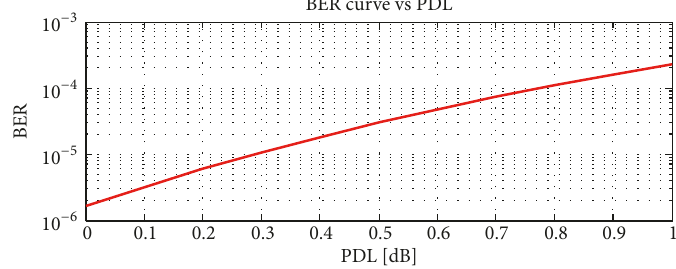
Figure 14: BER degradation due to PDL (P Rx = −19.4 dB, L = 60 km, (cid:2) 𝜗 = 5 ∘ , and f BR = 10 Gbit /